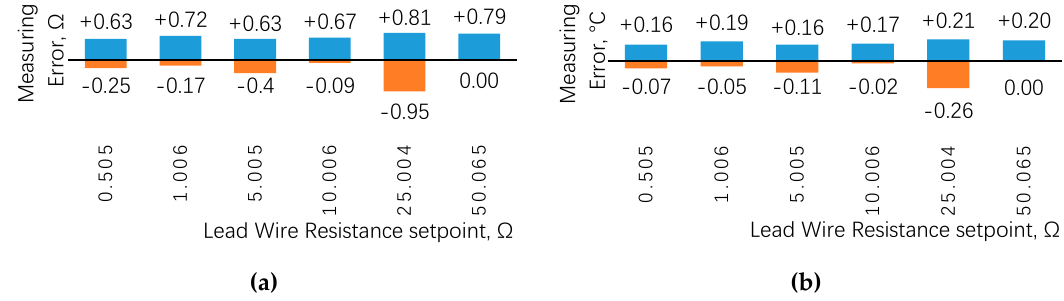
Figure 6. ( a ) Measurement errors of resistance under different lead wire resistance; ( b ) measurement errors of temperature under different lead wire resistance.